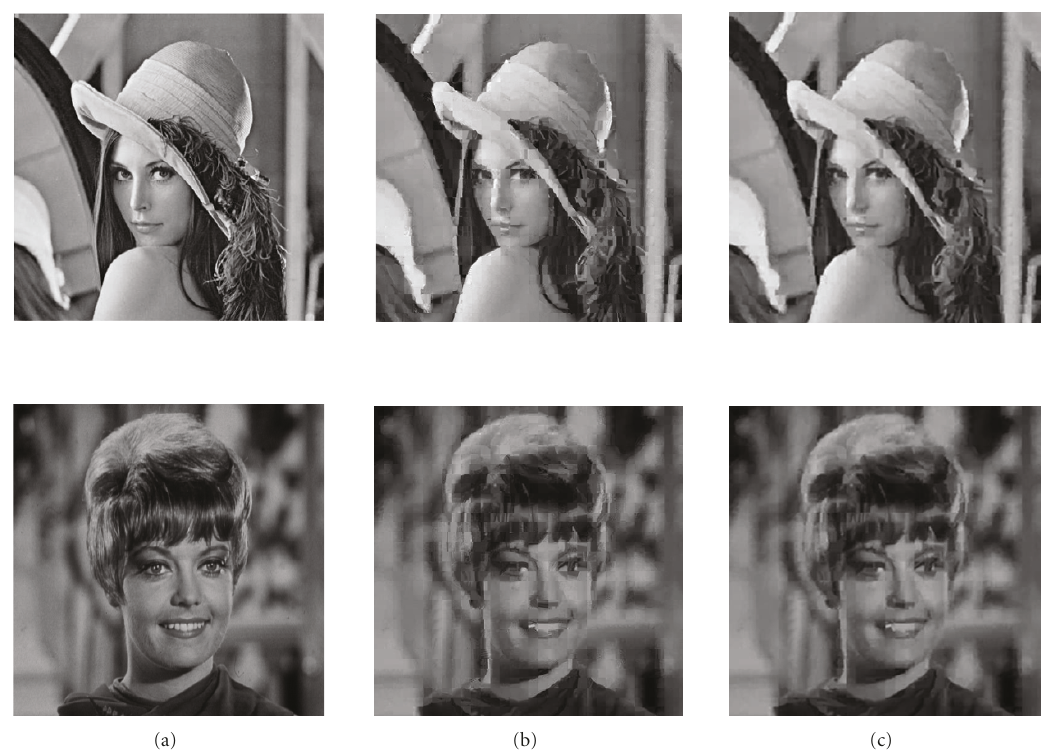
Figure 12: (a) Original, (b) reconstructed, and (c) filtered versions of the images (Lenna and F73) for the 2nd group of experiments. Lenna: PSNR = 25,20 and 25,87 (filtered), F73: PSNR = 29,58 and 30,36 (filtered) (CR =